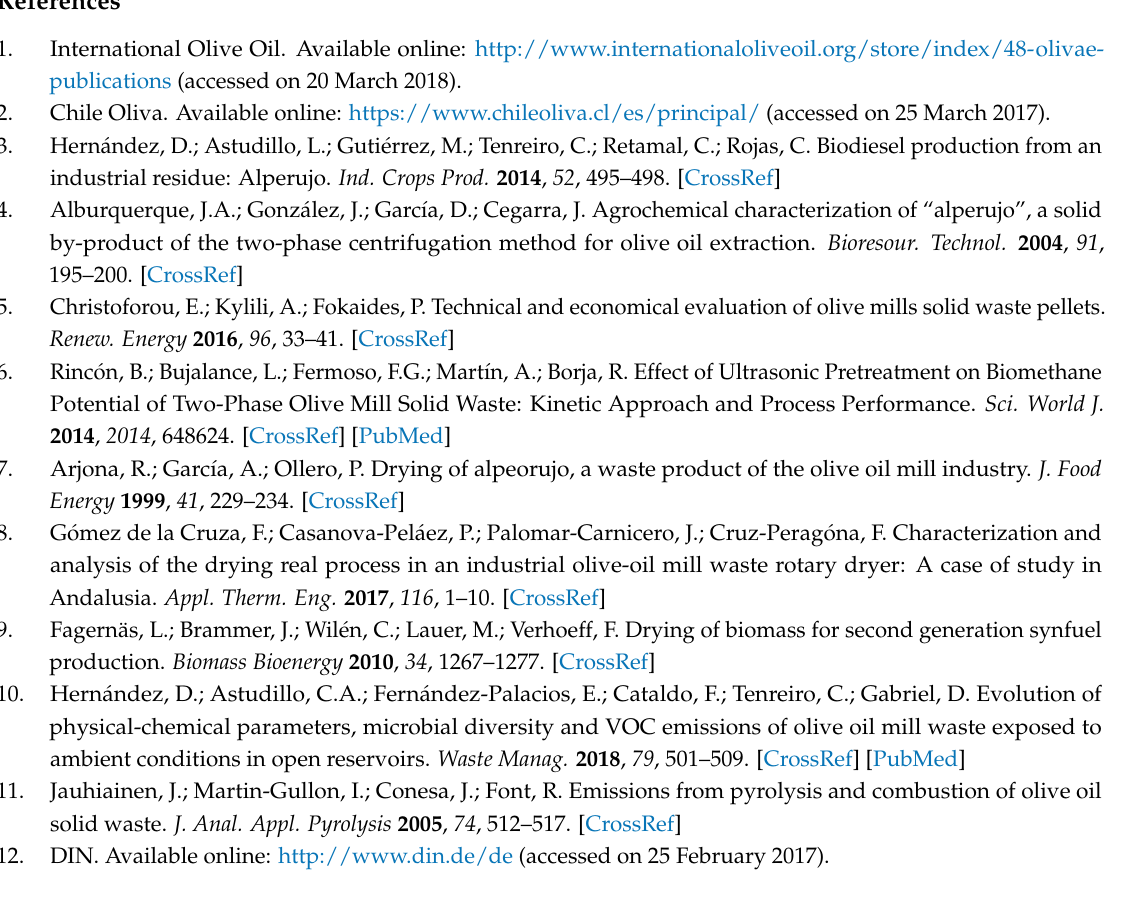
Table S1: Average monthly weather conditions (www.wolframalpha), Table S2: Results of the physical-chemical analysis with standard deviation for samples of alperujo and orujo as exit conditions to the drying trommel in